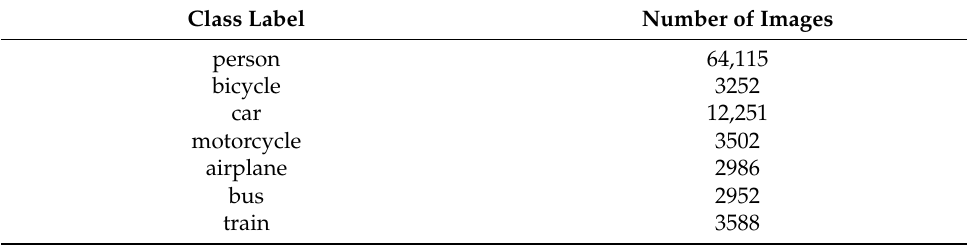
Table A3. Number of images associated with each class label in